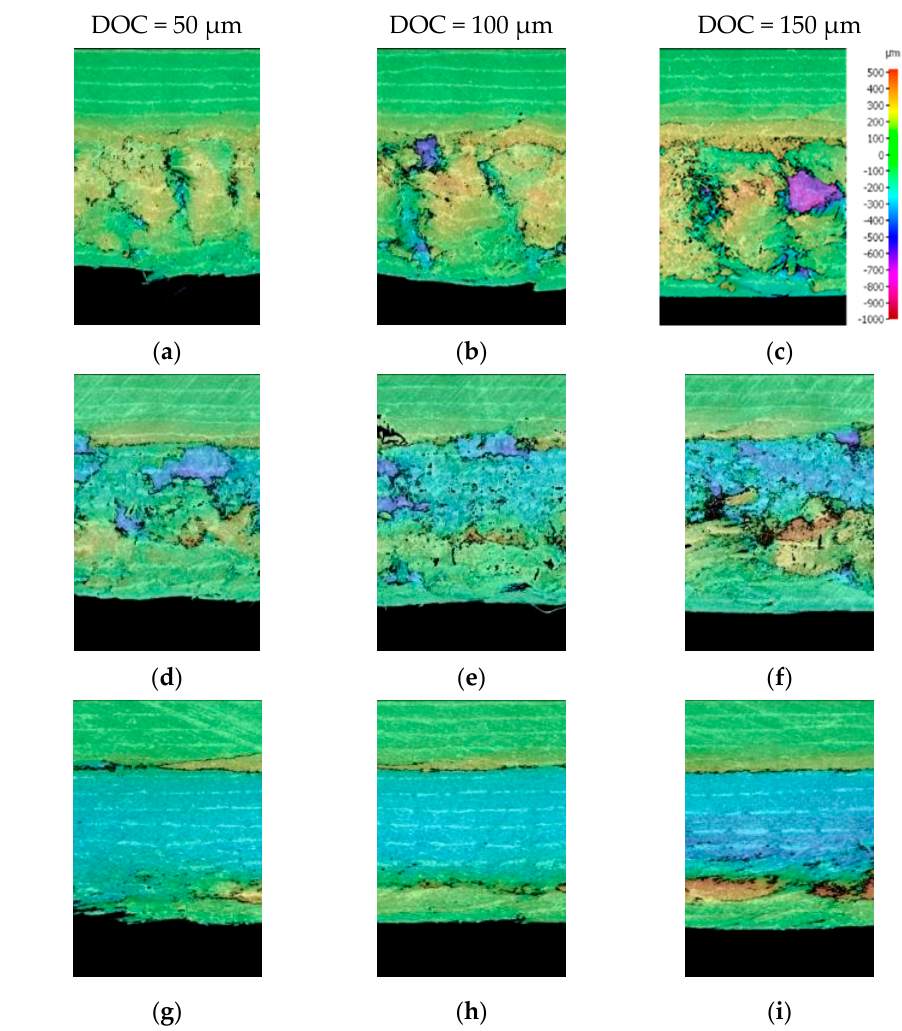
Figure 17. The measured depth of cut from scanned surface profile for fibre orientation of 135° and cutting speed of 12 mm/m at different rake angles of ( a – c ) − 10°; ( d – f ) 10°; and ( g – i ) 30°.